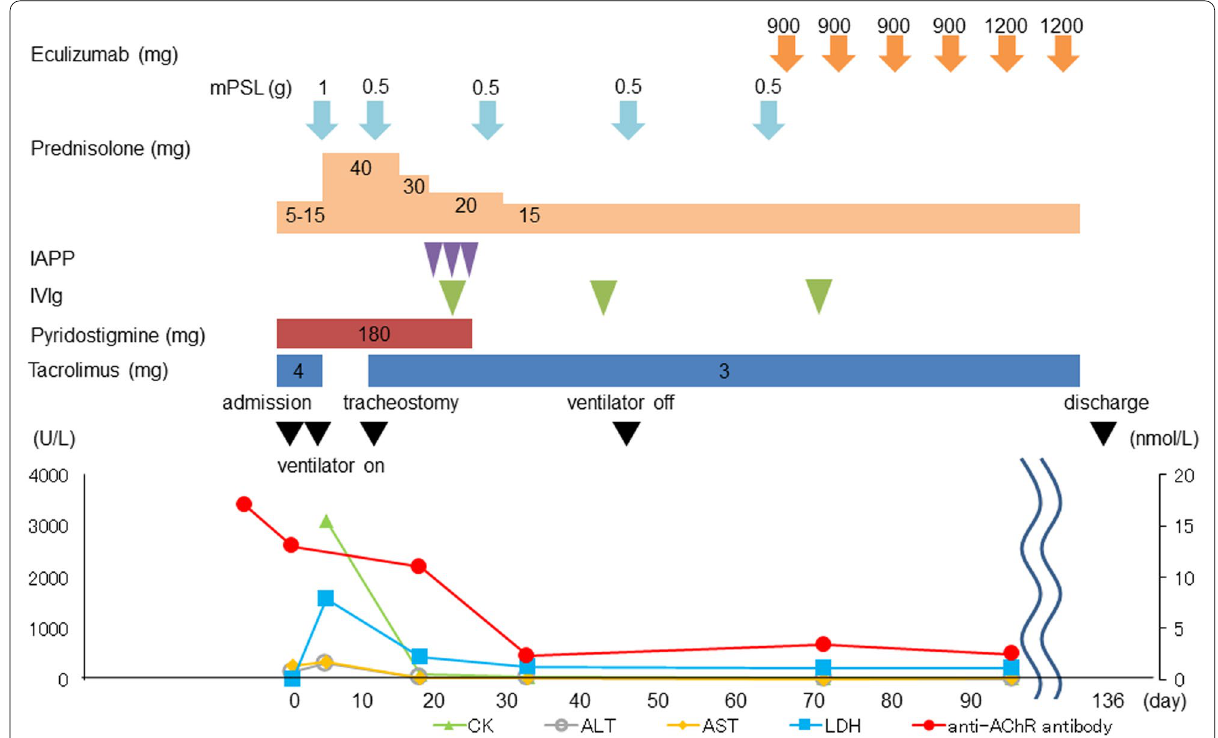
Fig. 3 Post-administration course and blood examination values. Muscle weakness did not recover quickly, even after the abnormal values